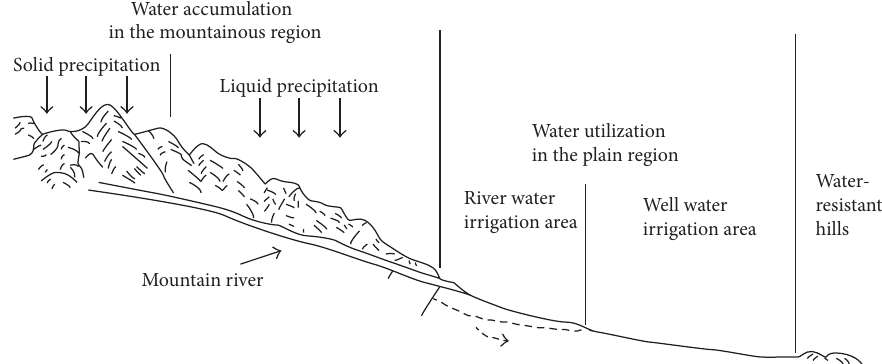
Figure 1: The relationship of water resources transformation in arid inland